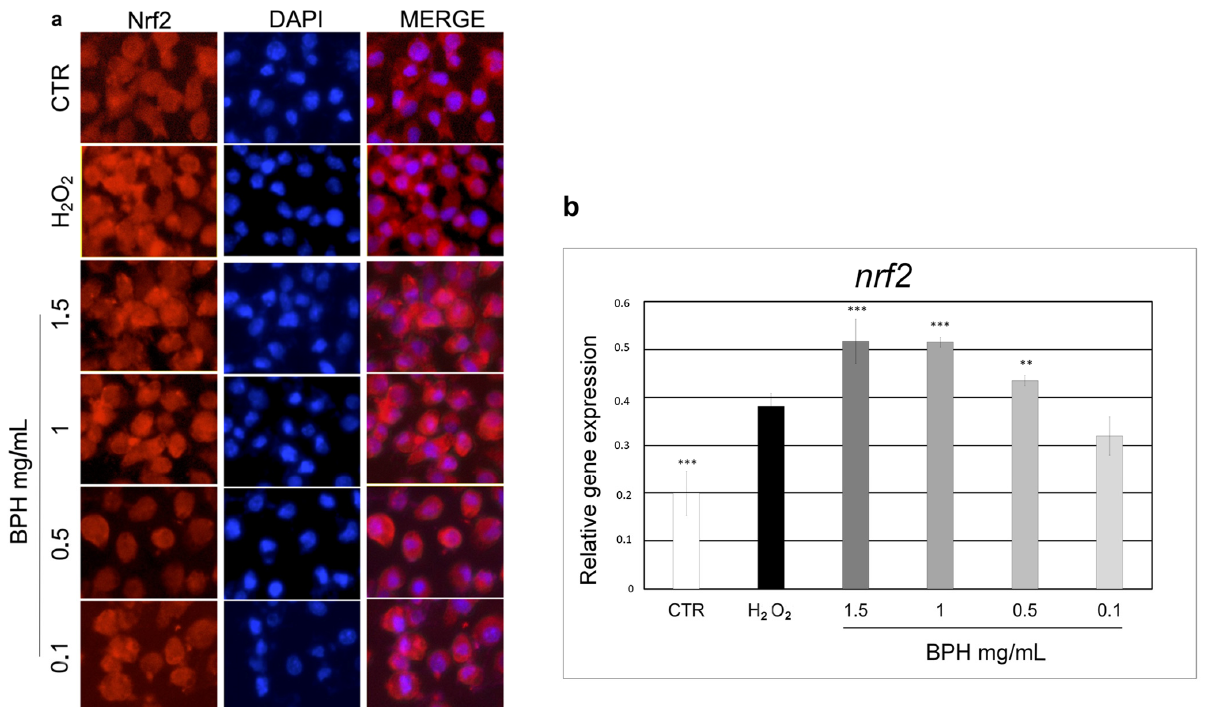
Figure 4. ( a ) Indirect immunofluorescence for Nrf2 expression and subcellular localization. For nuclear counterstaining, cells were stained with DAPI. ( b ) Relative mRNA levels of nrf2 in L-929 cells treated with BPHs in each experimental group. Data are expressed as mean ± S.D. ( n = 6). *** p < 0.001 vs. H 2 O 2 ; ** p < 0.01 vs. H 2 O 2